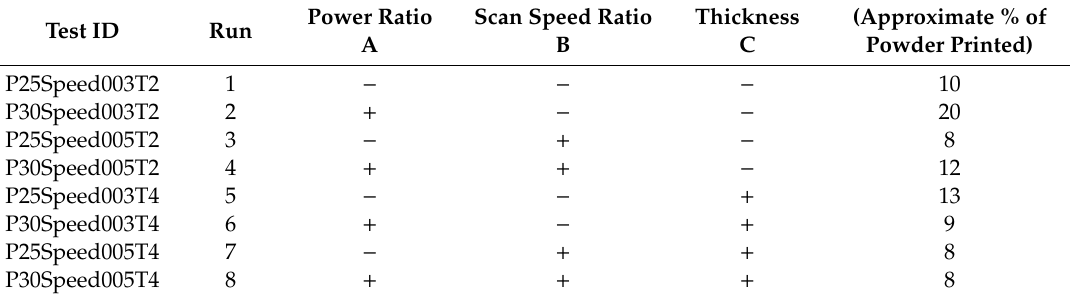
Table A5. Factorial design of experiments laser printing test matrix